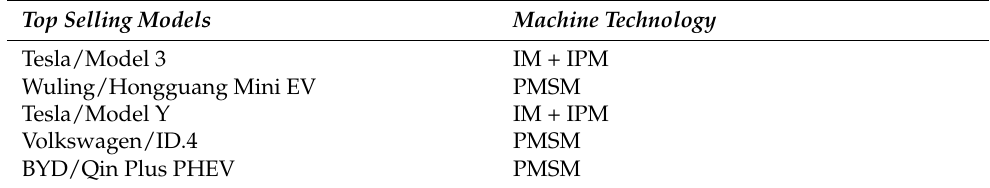
Table 1. Top selling EV models in 2021 and their machine technology